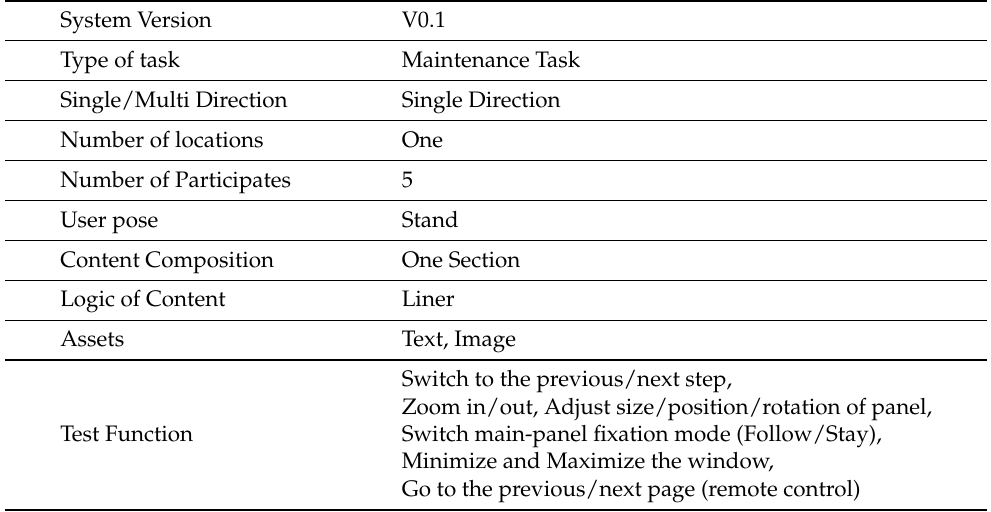
Table 3. The detail of the first case study.